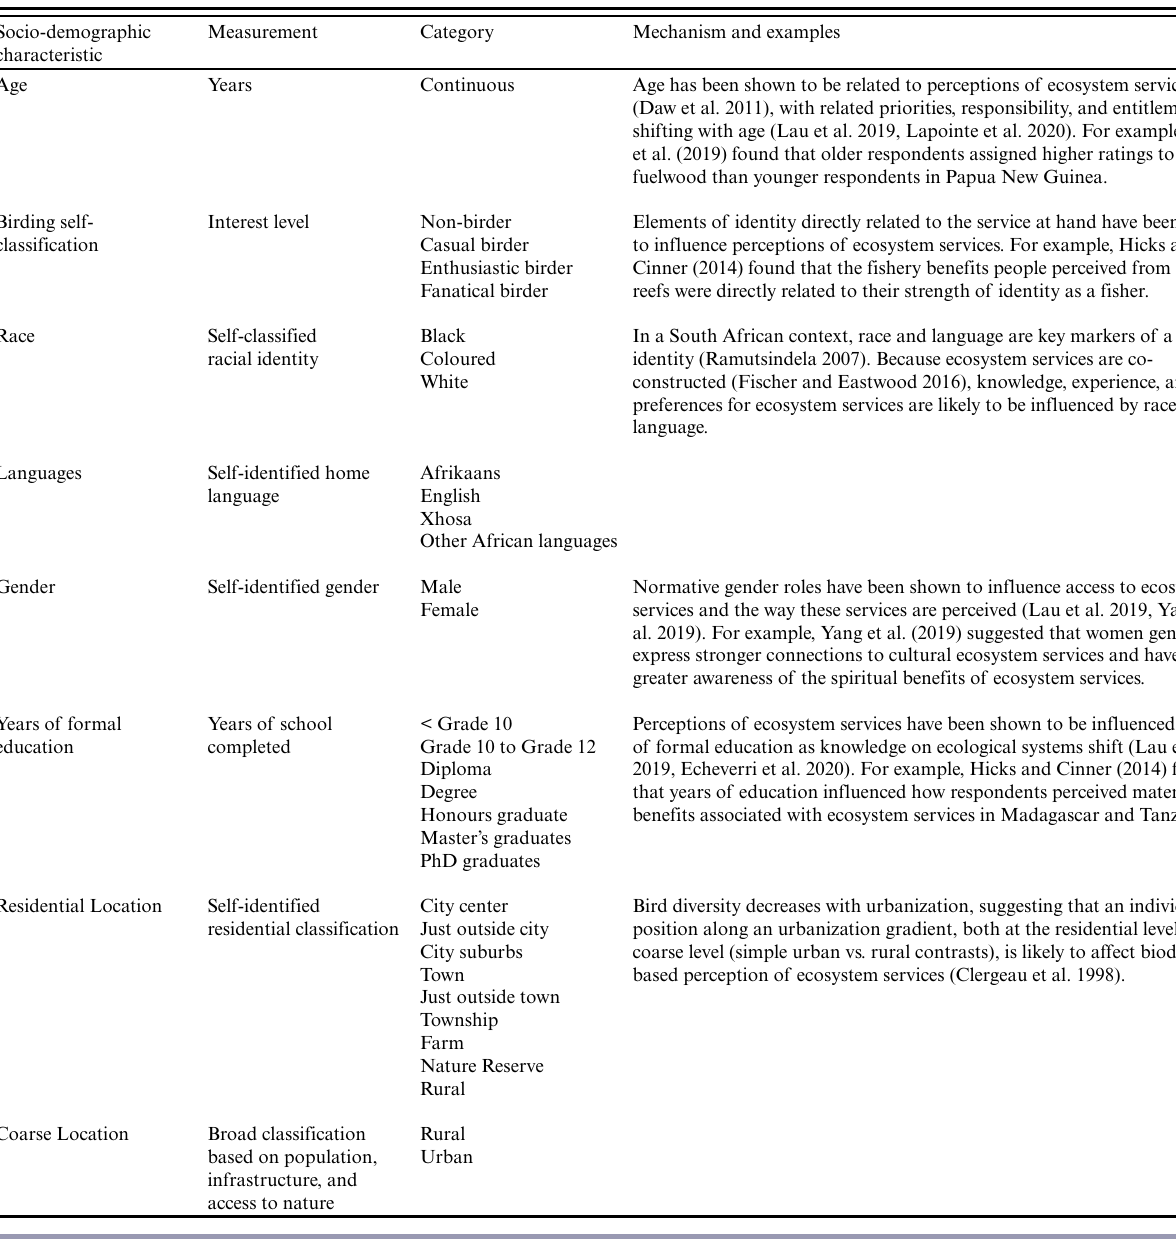
Table 1 . Socio-demographic characteristics of respondents, how they were measured, and how these characteristics might influence perception of ecosystem services, with